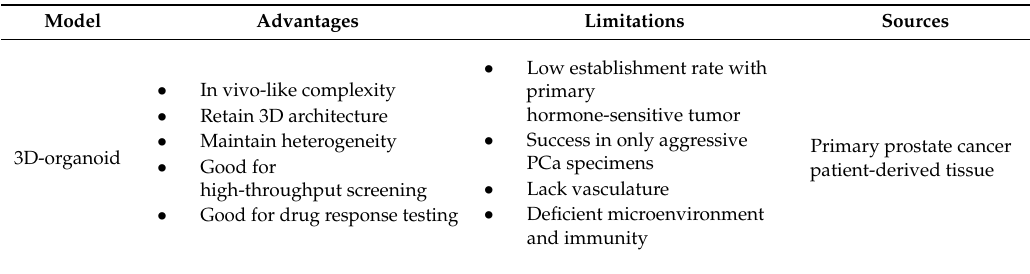
Table 2. The advantages and limitations of patient-derived xenograft